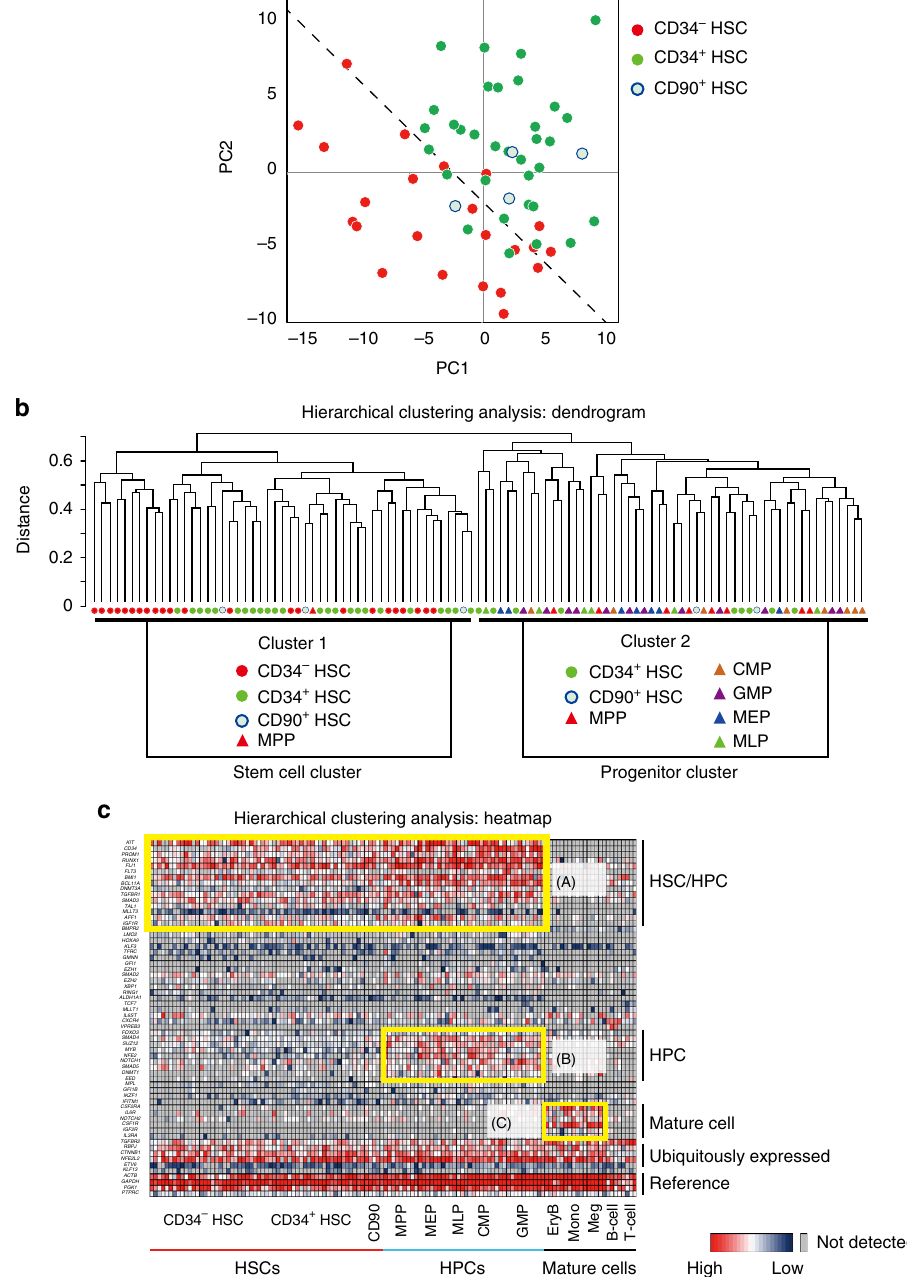
Fig. 4 Single-cell-based gene expression pro fi les of human CB-derived CD34 + and CD34 − HSCs. Using highly puri fi ed human CB-derived 18Lin − CD34 + CD38 − CD133 + GPI-80 + and 18Lin − CD34 − CD133 + GPI-80 + cells, we performed a single-cell-based gene expression analysis. The immunophenotypes